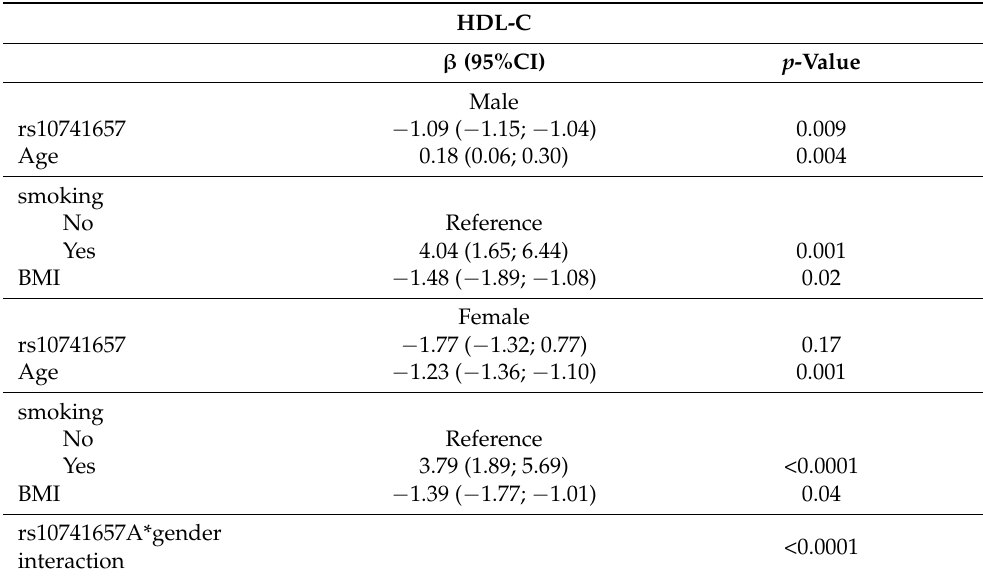
Table 4. Interaction analysis between rs10741657 and gender on high-density lipoprotein choles- terol